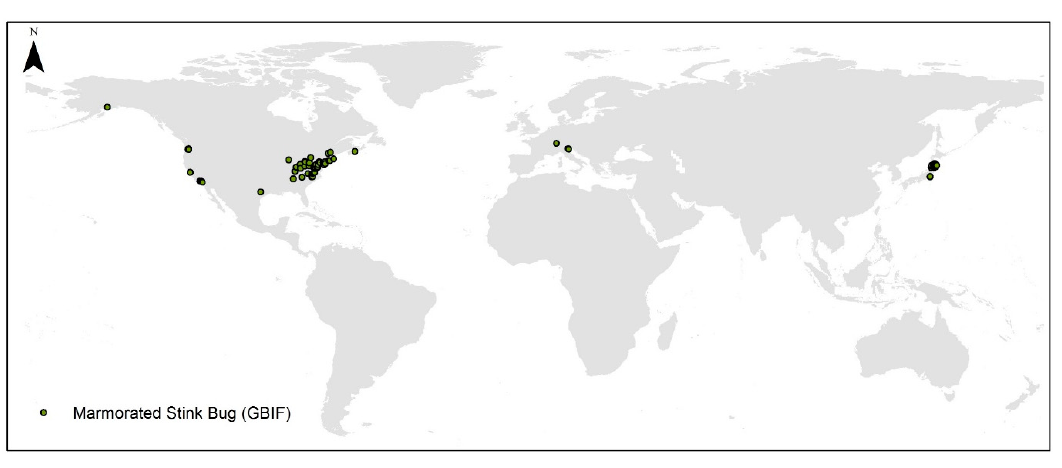
Figure 1. Global s patially rarified occurrence used in the model ( n = 125). Figure 1. Global spatially rarified occurrence used in the model ( n = 125).